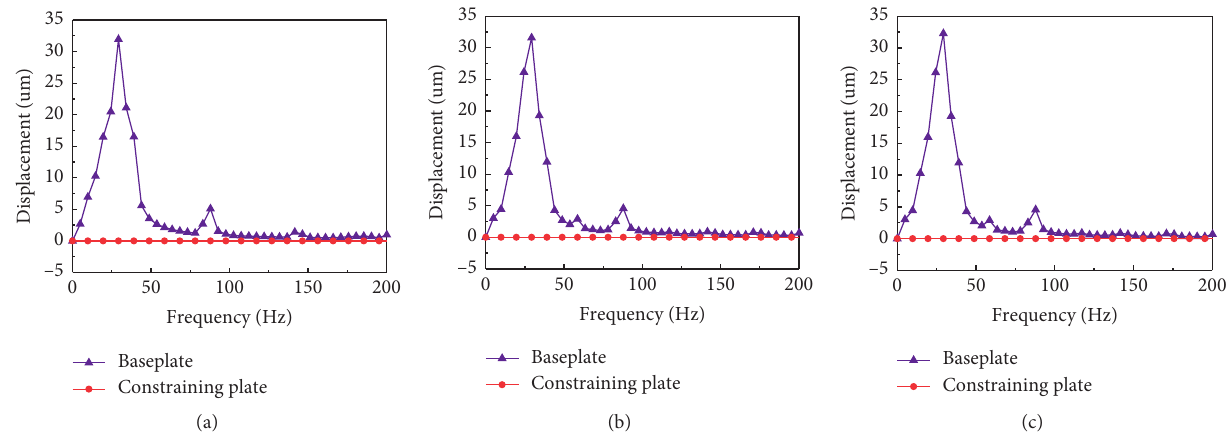
Figure 10: Displacement response of the baseplate and the constraining plate under three different boundary conditions (measure point D1). (Note: the displacement direction is positive in the vertical direction and negative in the opposite direction). (a) C-C-F-F, (b) C-C-C-F, and (c)